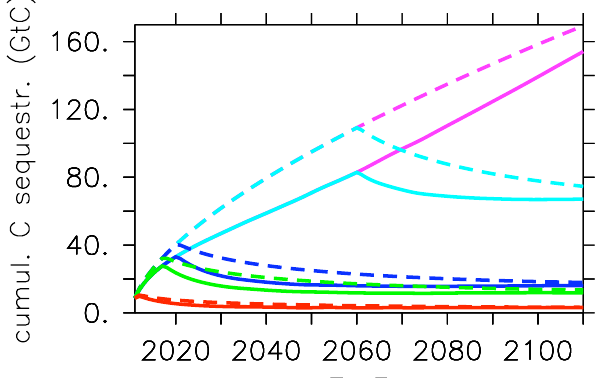
Fig. A3. As Fig. 11 of main text, but here for “upper bound” sensi- tivity experiment with µ max =10day − 1 in iron fertilized area. Solid lines: Cumulative temporal integral of the fertilization-induced re- duction in atmospheric CO 2 . Dashed lines: Cumulative temporal integral of the fertilization-induced change in global air-sea flux of CO 2 . Units are